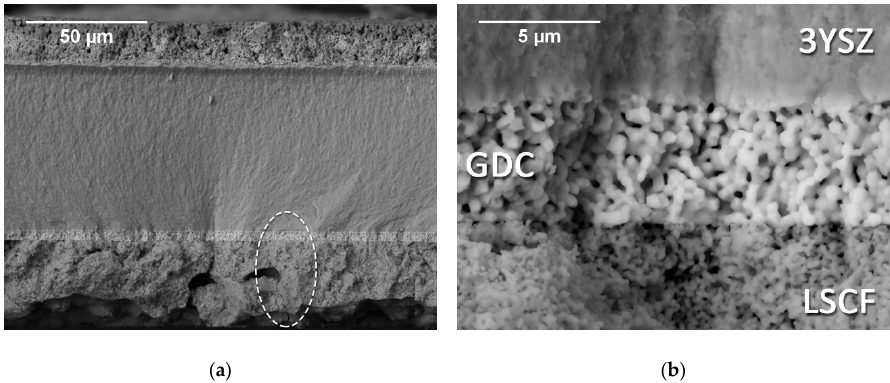
Figure 11. SEM images showing a typical fracture surface of a whole MEA (SO3) tested with the air electrode side in tension. The circle in ( a ) highlights a pre-crack in the air electrode. ( b ) Detail of the fracture initiation site at the interface between the LSCF air electrode and the GDC barrier layer.